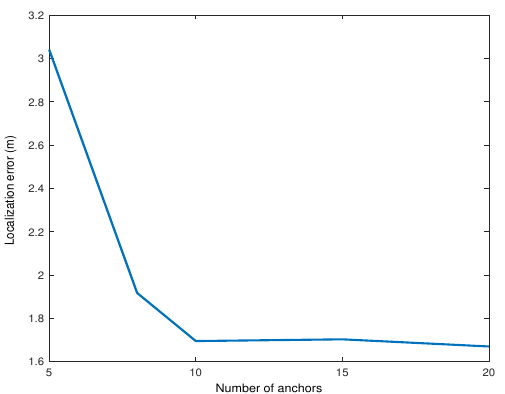
Figure 2. The localization error using 35 unknown nodes with the varying number of anchors in 400 m 2 applying Adam for sigma shadowing =